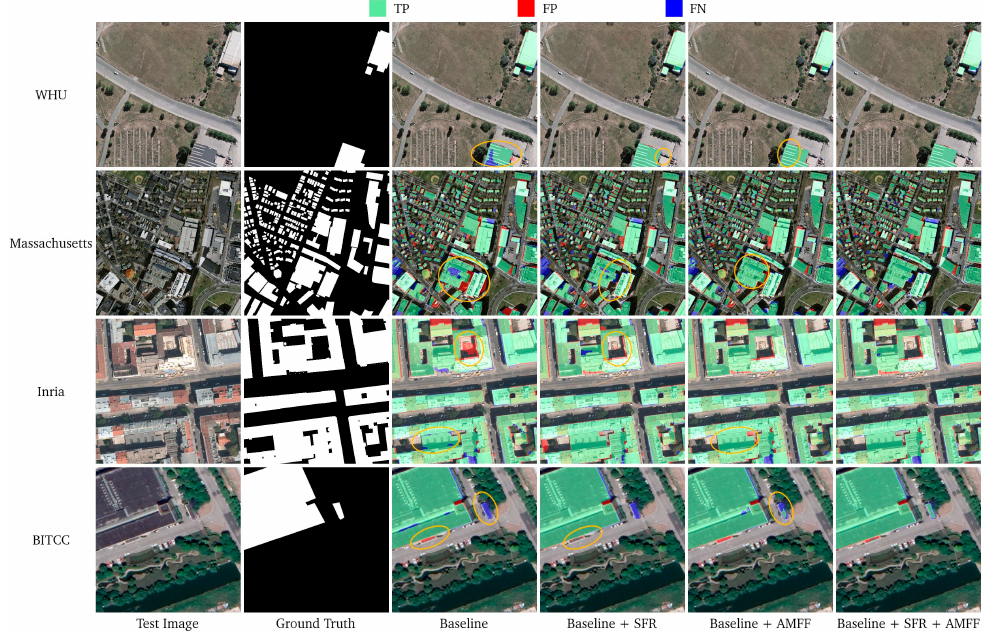
Figure 15. Samples of building extraction results by different models with four datasets (ablation study).